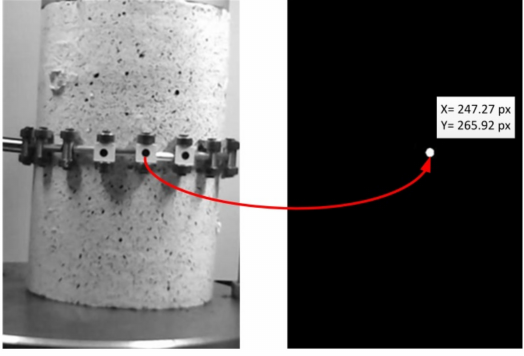
Figure 5. Target detection and